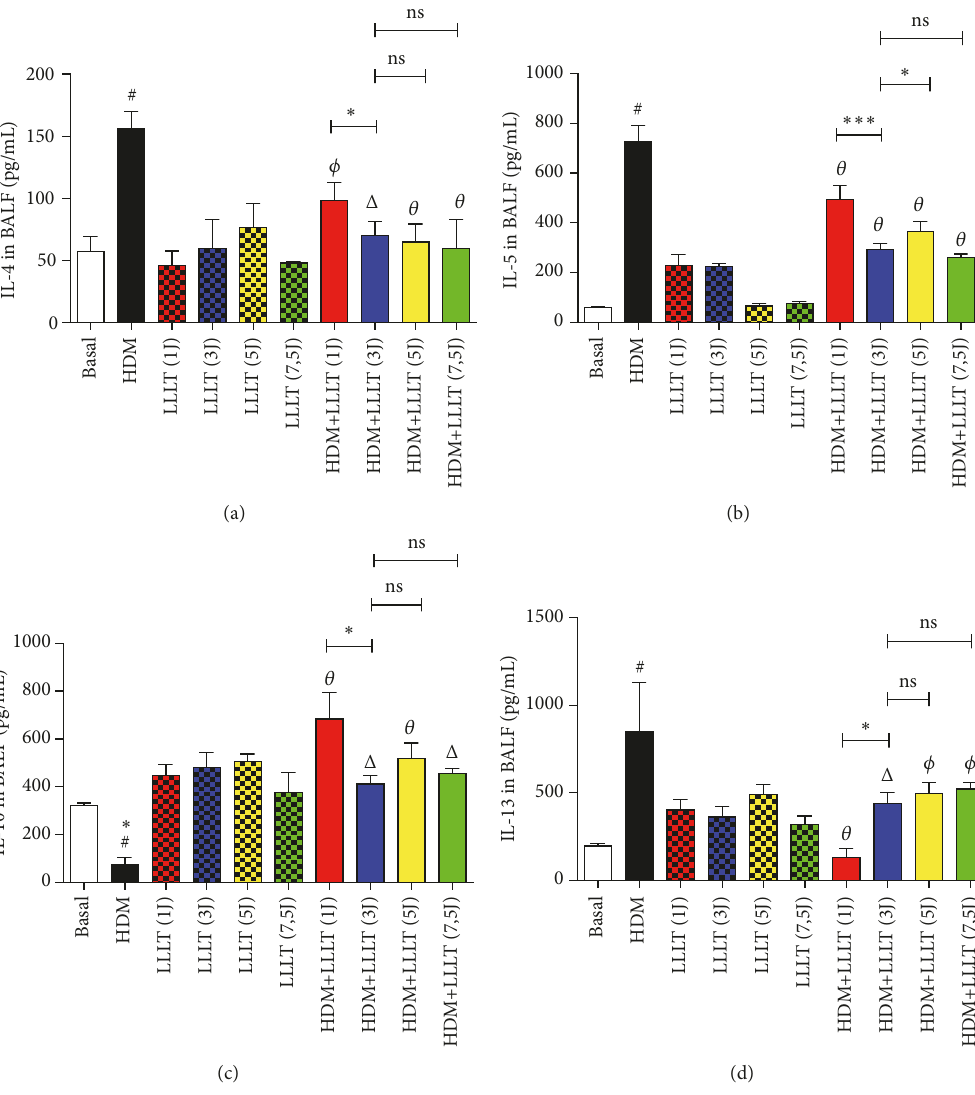
Figure 2: Effect of LLLT on IL-4 (a), IL-5 (b), IL-10 (c), and IL-13 (d) levels in BALF supernatant. Values expressed as mean and standard deviation. The groups used in the experiment are described in Figure 1. The results refer to the use of 10 mice in each experimental group. # p < 0.001 and ∗ # p < 0.01 when compared to the Basal group; 𝜃 p < 0.001, Δ p < 0.01, and 𝜙 p < 0.05 when compared to the asthmatic group (HDM) and ns (not significant); ∗ p < 0,05 and ∗ ∗∗ p < 0,001 when compared HDM+LLLT (3J) group with the other groups treated with other